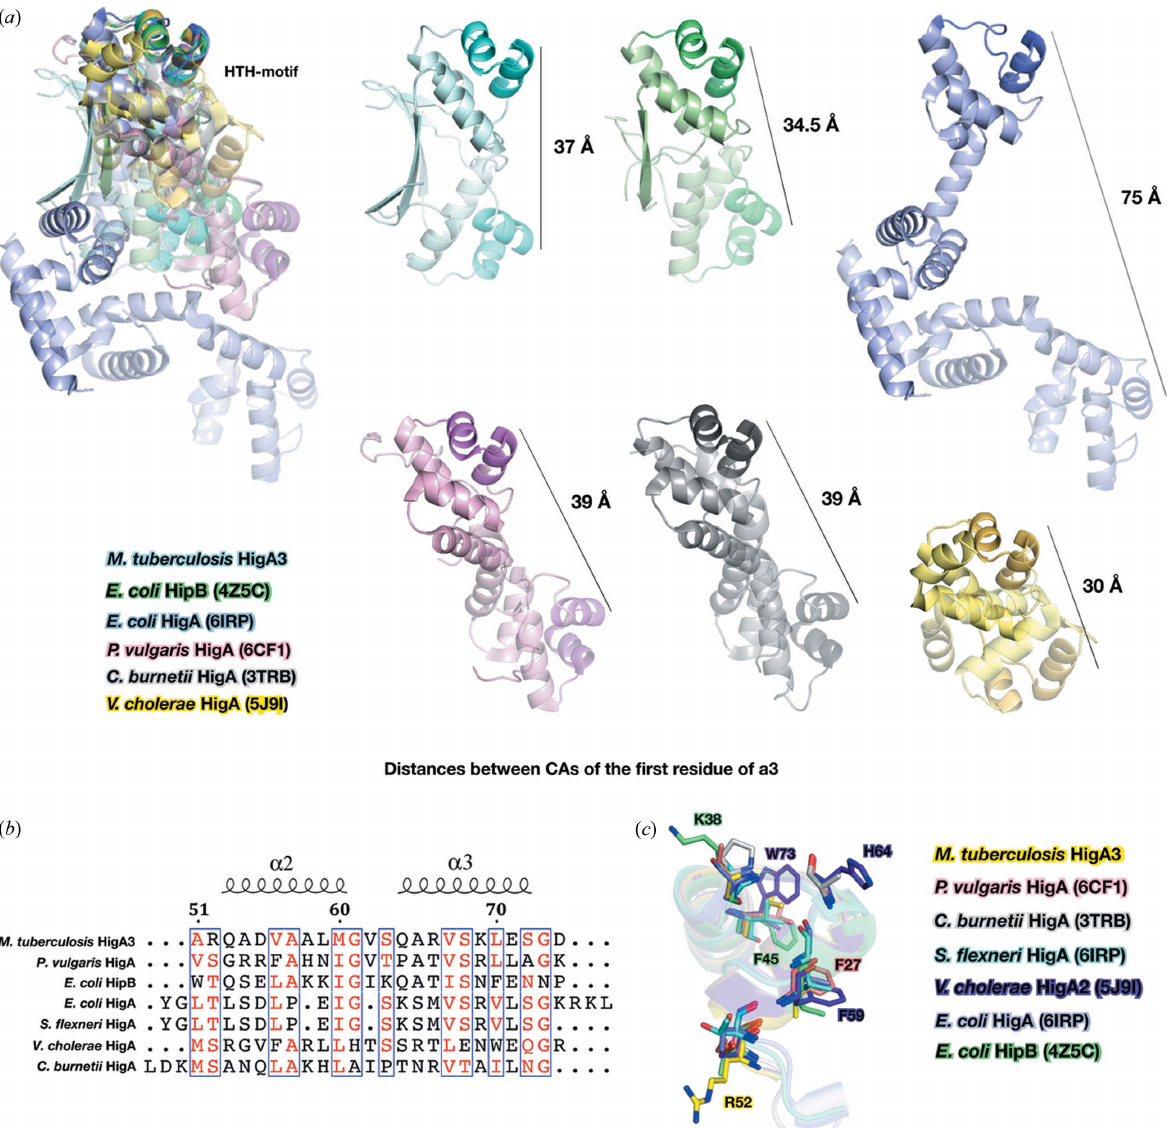
Figure 2 Sequence and structural comparison of Mt HigA3 with other homologues. ( a ) Superposition and structural comparison of Mt HigA3 with the structures of E. coli HipB (lime green, PDB code: 4z5c), E. coli HigA (slate, PDB code: 6irp; Yoon et al. , 2019), P. vulgaris HigA (pink, PDB code: 6cf1; Schureck et al. , 2019), C. burnetii HigA (grey, PDB code: 3trb; Franklin et al. , 2015) and V. cholerae HigA (yellow, PDB code: 5j9i; Hadzˇi et al. , 2017). The adjacent chain of each dimer is coloured lighter, and HTH motifs are coloured darker. The distances between CAs of the first residue of the (cid:3) 3-helix are shown as black lines. ( b ) Sequence alignment focusing on the HTH motif region in M. tuberculosis HigA3, P. vulgaris HigA, E. coli HipB, E. coli HigA, S. flexneri HigA, V. cholerae HigA and C. burnetii HigA. Similar residues are coloured red in the box. Secondary structural elements of Mt HigA3 are presented above the sequence, where the helices are indicated by springs. The residue numbering corresponds to M. tuberculosis HigA3. ( c ) Superposition of the HTH motif of M. tuberculosis HigA3 (yellow) with the structures of P. vulgaris HigA (pink, PDB code: 6cf1), E. coli HipB (lime green, PDB code: 4z5c), E. coli HigA (slate, PDB code: 6irp), S. flexneri HigA (cyan, PDB code: 5ycl), V. cholerae HigA (purple blue, PDB code: 5j9i) and C. burnetii HigA (grey, PDB code: 3trb). Positively charged residues and aromatic residues are shown as